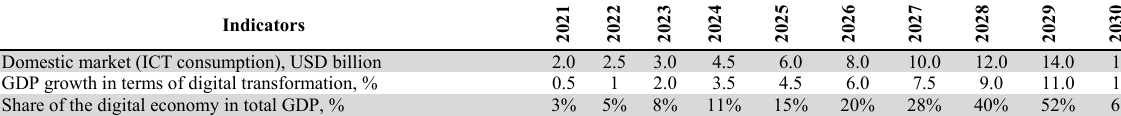
Forecast indicators of digital transformation of the economy and society in Ukraine Indicators